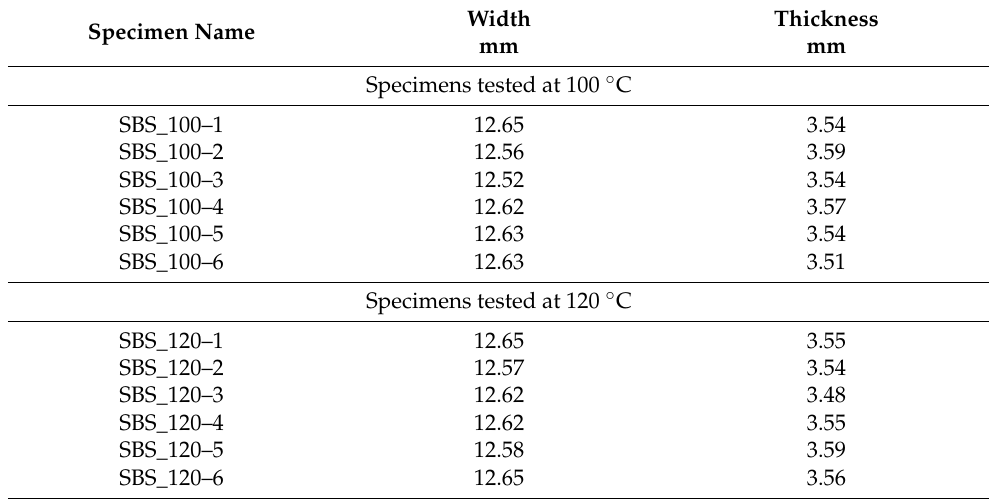
Table 1. Dimensions of the SBS Specimens tested at 100 ◦ C and 120 ◦